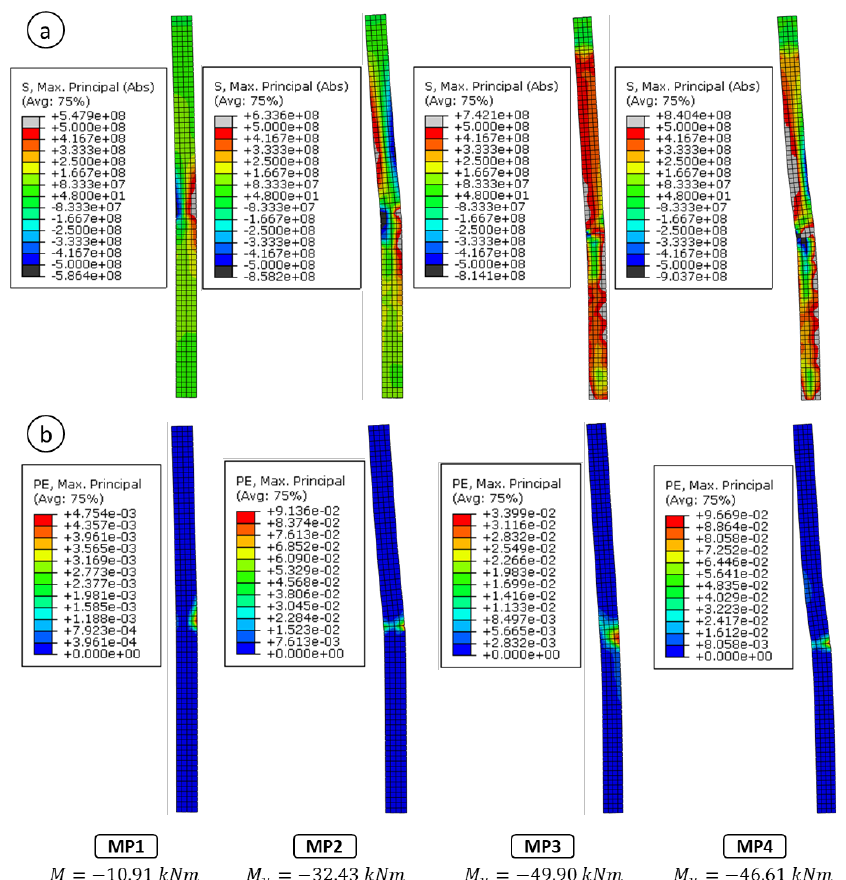
Figure 18. Anchors. a) Main maximum stresses; b) Main maximum strains. (Stresses in